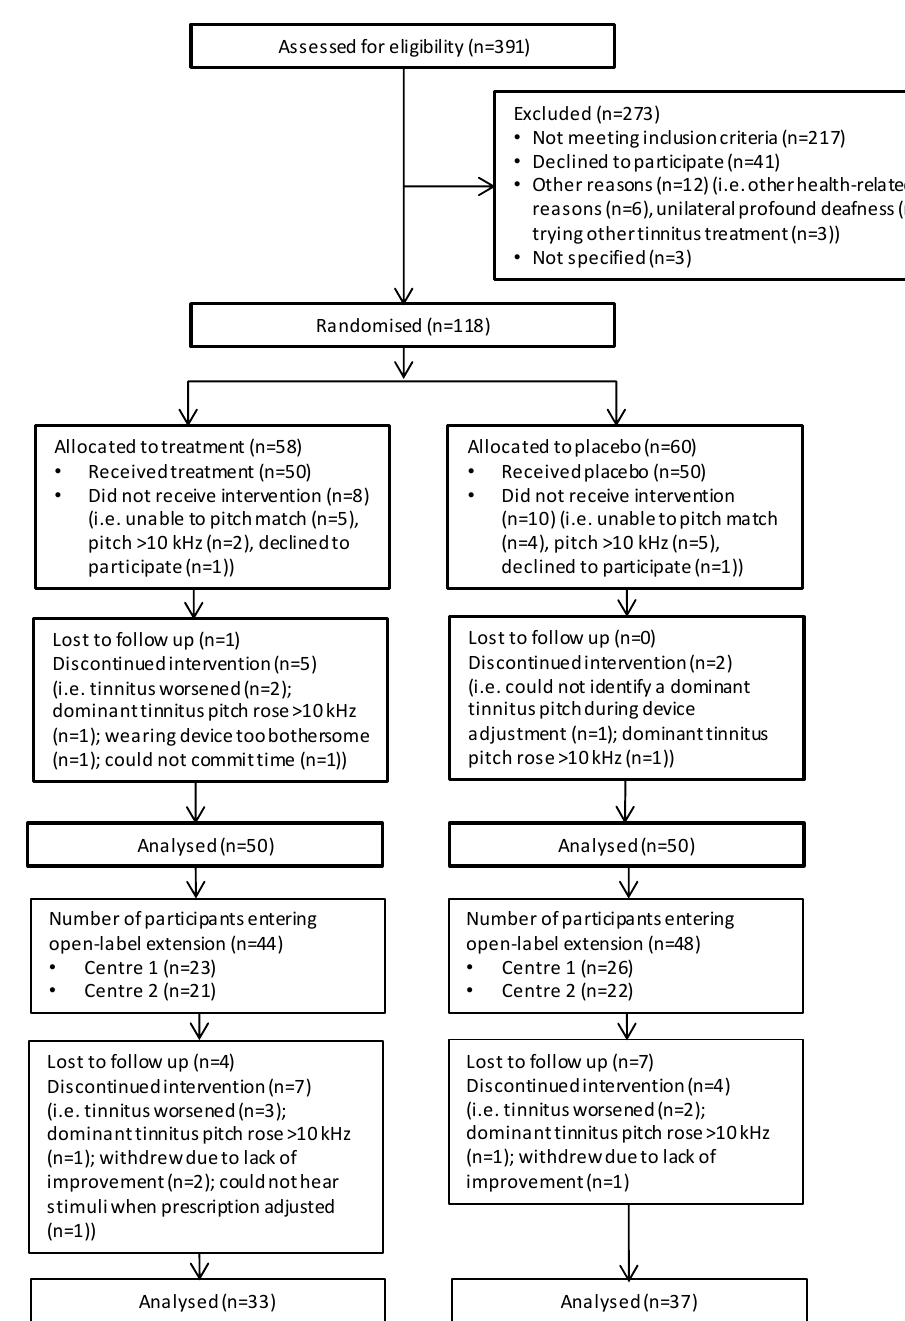
Figure 2. Flow chart for the RESET2 clinical trial. RCT phase is denoted by the thicker outlined boxes.